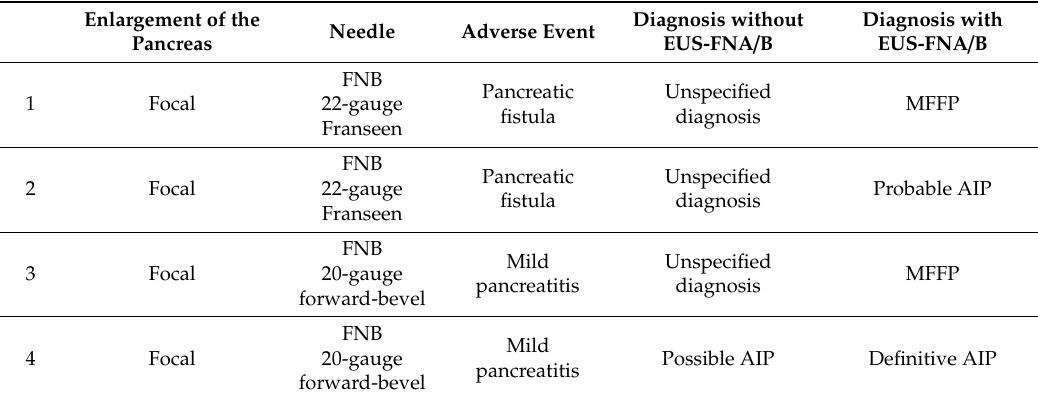
Table 2. Adverse events of endoscopic ultrasonography-guided fine needle aspiration / biopsy. Enlargement of the Needle Adverse Pancreas